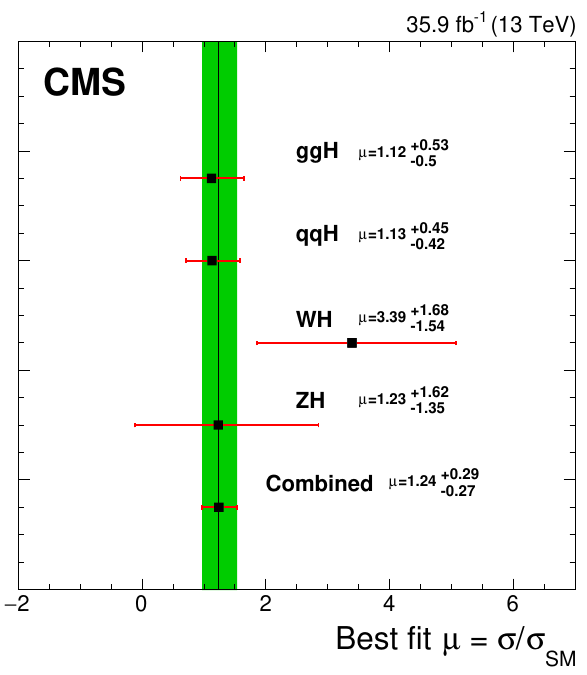
Figure 6 . Best (cid:12)t signal strength per Higgs boson production process, for m H = 125 GeV, using a combination of the WH and ZH targeted analysis detailed in this paper with the CMS analysis performed in the same data set for the same decay mode but targeting the gluon fusion and vector boson fusion production mechanisms [19]. The constraints from the combined global (cid:12)t are used to extract each of the individual best (cid:12)t signal strengths. The combined best (cid:12)t signal strength is (cid:22) = 1 : 24 +0 : 29 (cid:0) 0 : 27